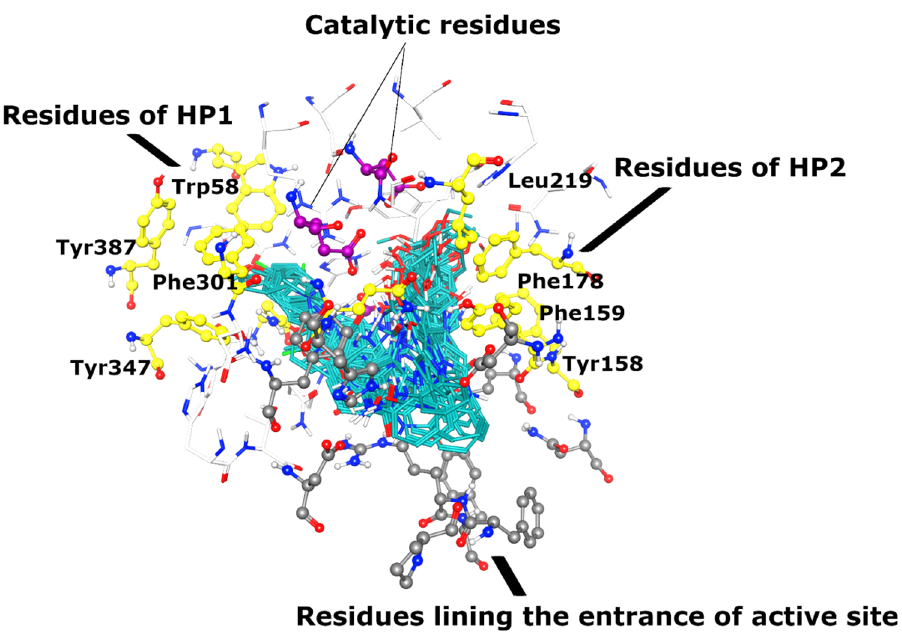
Figure 4. The docked orientation of all the compounds (cyan stick model) is shown with interacting residues. The residues of hydrophobic pocket 1 (HP1) and 2 (HP2) are shown in yellow ball and stick model. The residues of the active site entrance loop are shown in grey ball and stick model. The extended residues of active site are presented in white stick